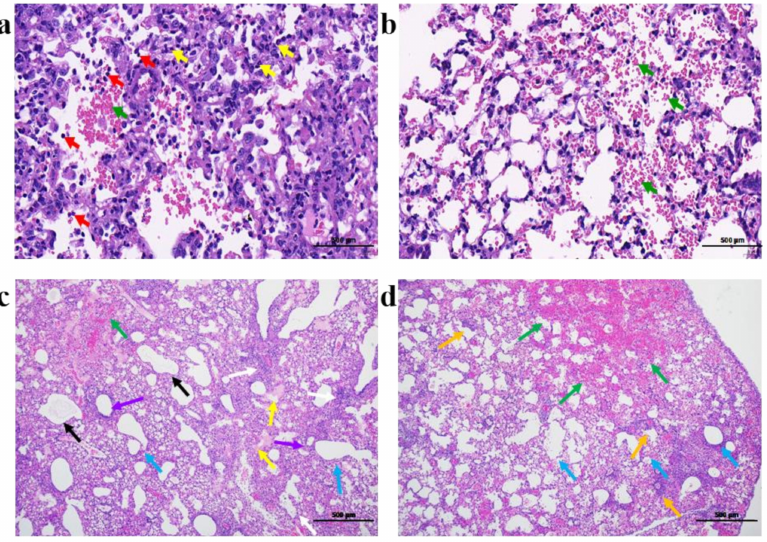
Figure 2. Pathological sections of mice lungs after infection with the four AIV strains: ( a ) GZA1: inflammatory cell exudation (red arrow), local bleeding (green arrow), and a large amount of in- flammatory cell infiltration on the alveolar wall (orange arrow); ( b ) XJ47: local bleeding (green arrow); ( c ) P12-GZA1: eosinophilic fibrin exudation in the alveoli (black arrow), hyaline membrane formation (yellow arrow), small-scale hemorrhage (green arrow), alveolar cystic dilatation (blue arrow), incomplete bronchial epithelium, nucleolar clear and cytoplasm alkaline in epithelial cells (purple arrow), and infiltration of inflammatory cells (white arrow); ( d ) P12-XJ47: intra-alveolar hemorrhage (green arrow), focal infiltration of perivascular inflammatory cells (orange arrow), and alveolar cystic dilatation (blue arrow).